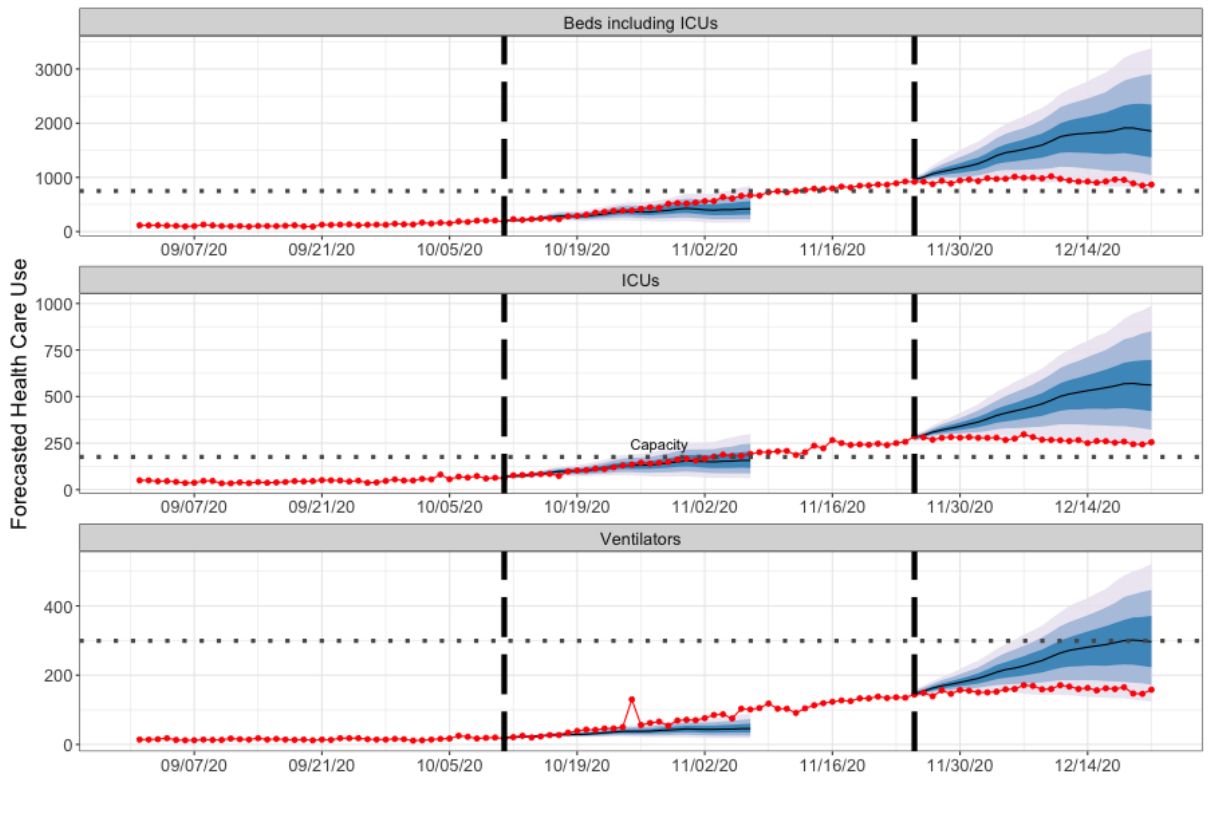
Figure 4. Reported health care use and example forecasts for New Mexico from October and November 2020. The numbers of concurrent hospitalization beds, ICU beds, and ventilators needed throughout hospitals in New Mexico from September 1 to December 29, 2020 (red points and line). Forecasts are day-ahead predicted medians (black line), and the 50%, 80% and 95% prediction intervals for 28 days (4 weeks). We show two examples, the